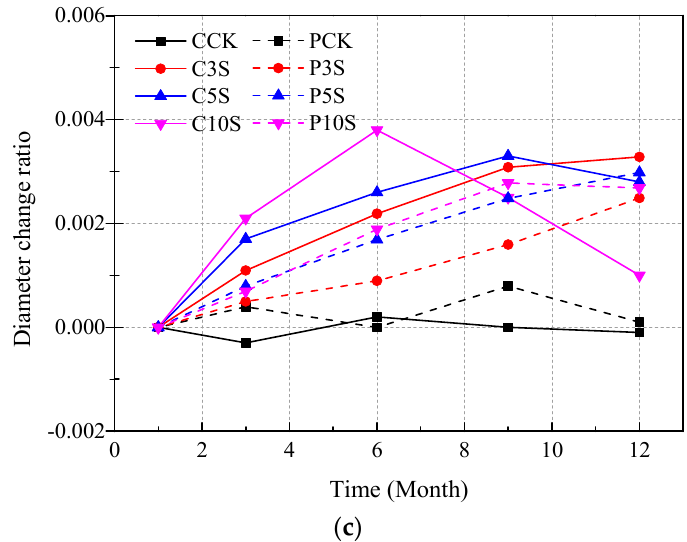
Figure 4. Diameter change ratios for concrete with di ff erent water / cement ratios: ( a ) 0.40, ( b ) 0.48, and ( c ) 0.55.